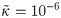
Graphs showing the evolution of α, β, and λ on logarithmic scales for.(a) low value of substrate stiffness κ˜=10−6, and (b) high substrate stiffness κ˜=0.1, from different initial conditions. The final steady state reached for (a): λ = 412, β < 1 and α = 1.6, and for (b): λ < 1, β = 108 and α = 2718.